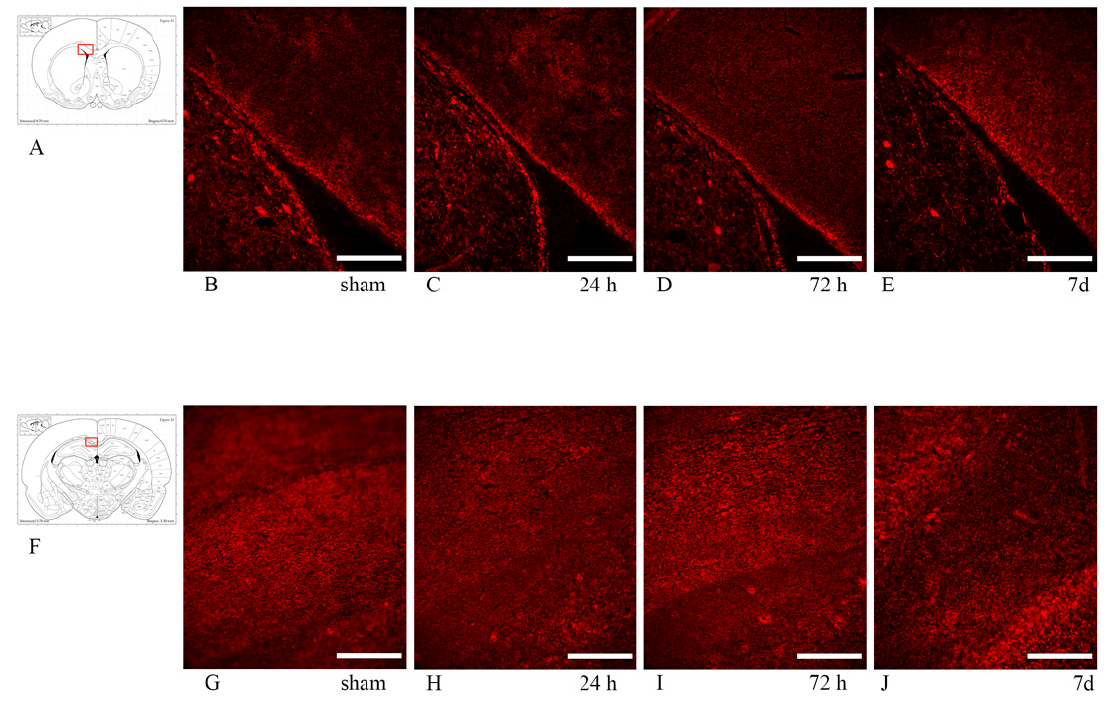
Figure 10. Rip (top row) and MBP (bottom row) expression in the corpus callosum. Fluorescence microscopy photographs of the corpus callosum (coronal sections) in di ff erent regions of interest. MBP and Rip stainings identify the myelin sheath. ( A , F ) The highlighted area refers to the area represented in each row. ( B – E ) anti-Rip antibody expression in the corpus callosum at around 1 mm from bregma, adjacent to the lateral ventricle. Rip expression appears similar between sham and exposed animals at all timepoints. ( G – J ) anti-MBP antibody expression in the corpus callosum at around − 3 mm from bregma. No clear di ff erence is noted between sham and exposed animals at all timepoints. Scale bar = 200 μ m.